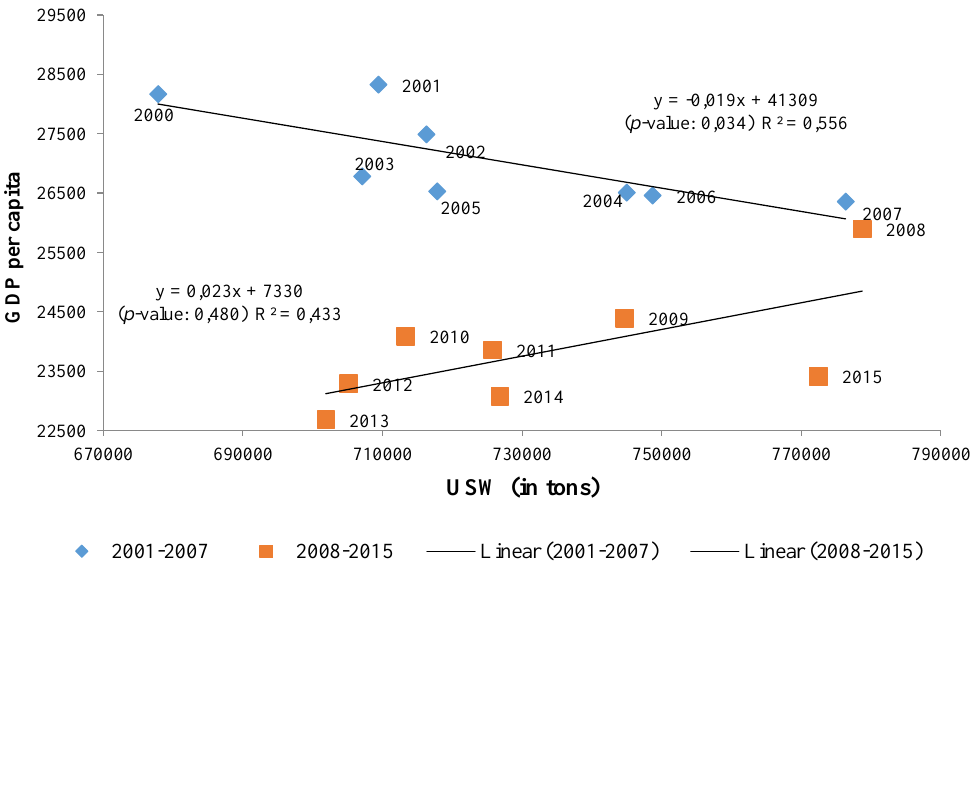
Figure 3: Linear Regression between USW (in tons) and GDP per